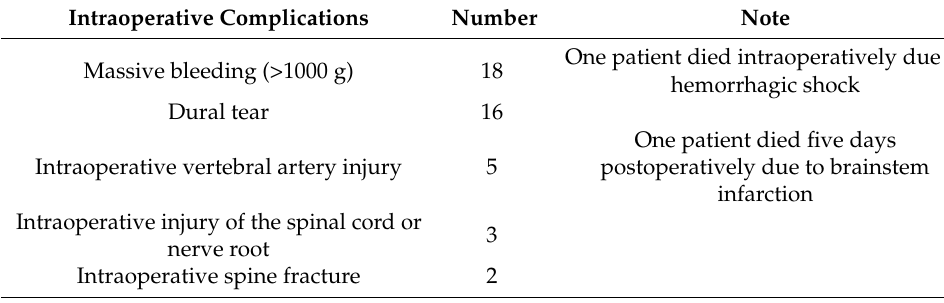
Table 3. Details of intraoperative complications.